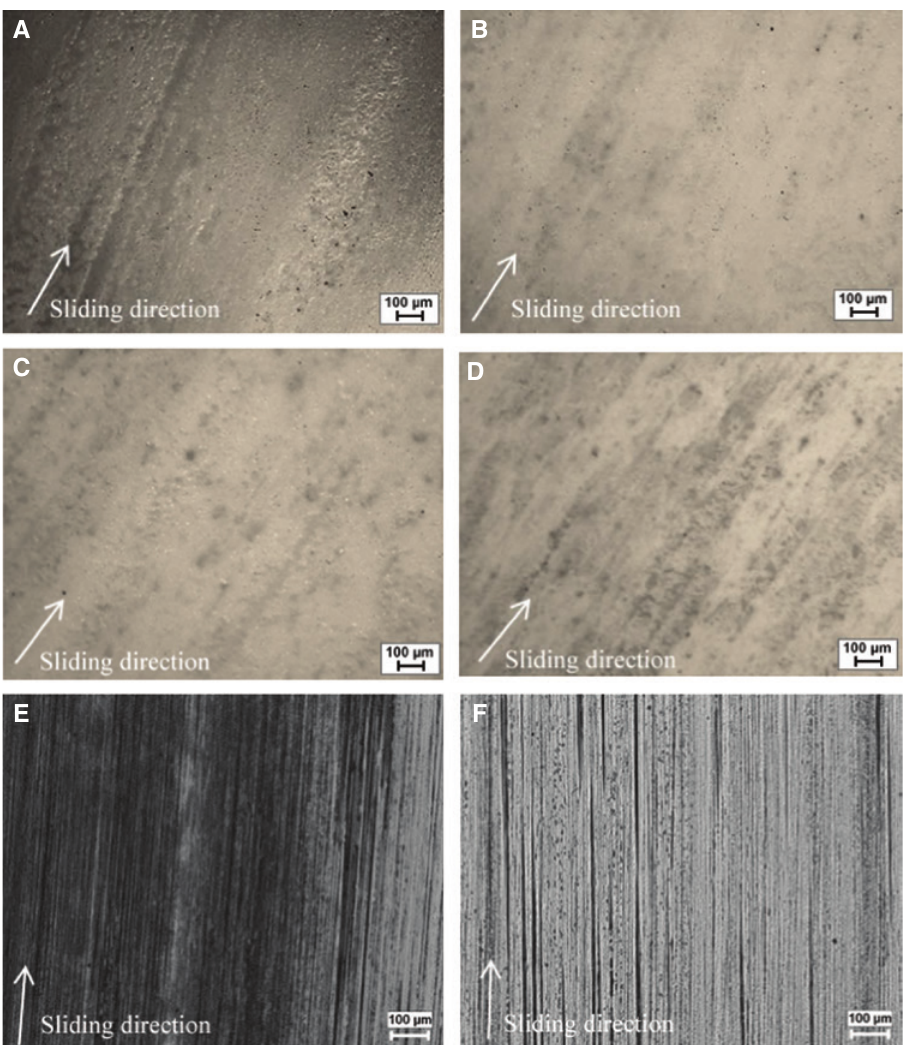
epoxy composites at 0.4 m/s sliding speed and 15 N load conditions. Figure 7: Optical micrographs of worn pin and disc surfaces of TiO 2 (A) Worn pin surface of pure epoxy, (B) worn pin surface of 10 wt% TiO -filled epoxy composite, (C) worn pin surface of 20 wt% TiO 2 epoxy composite, (D) worn pin surface of 30 wt% TiO -filled epoxy composite, (E) worn disc surface of pure epoxy, and (F) worn disc 2 surface of 30 wt% TiO -filled epoxy 2